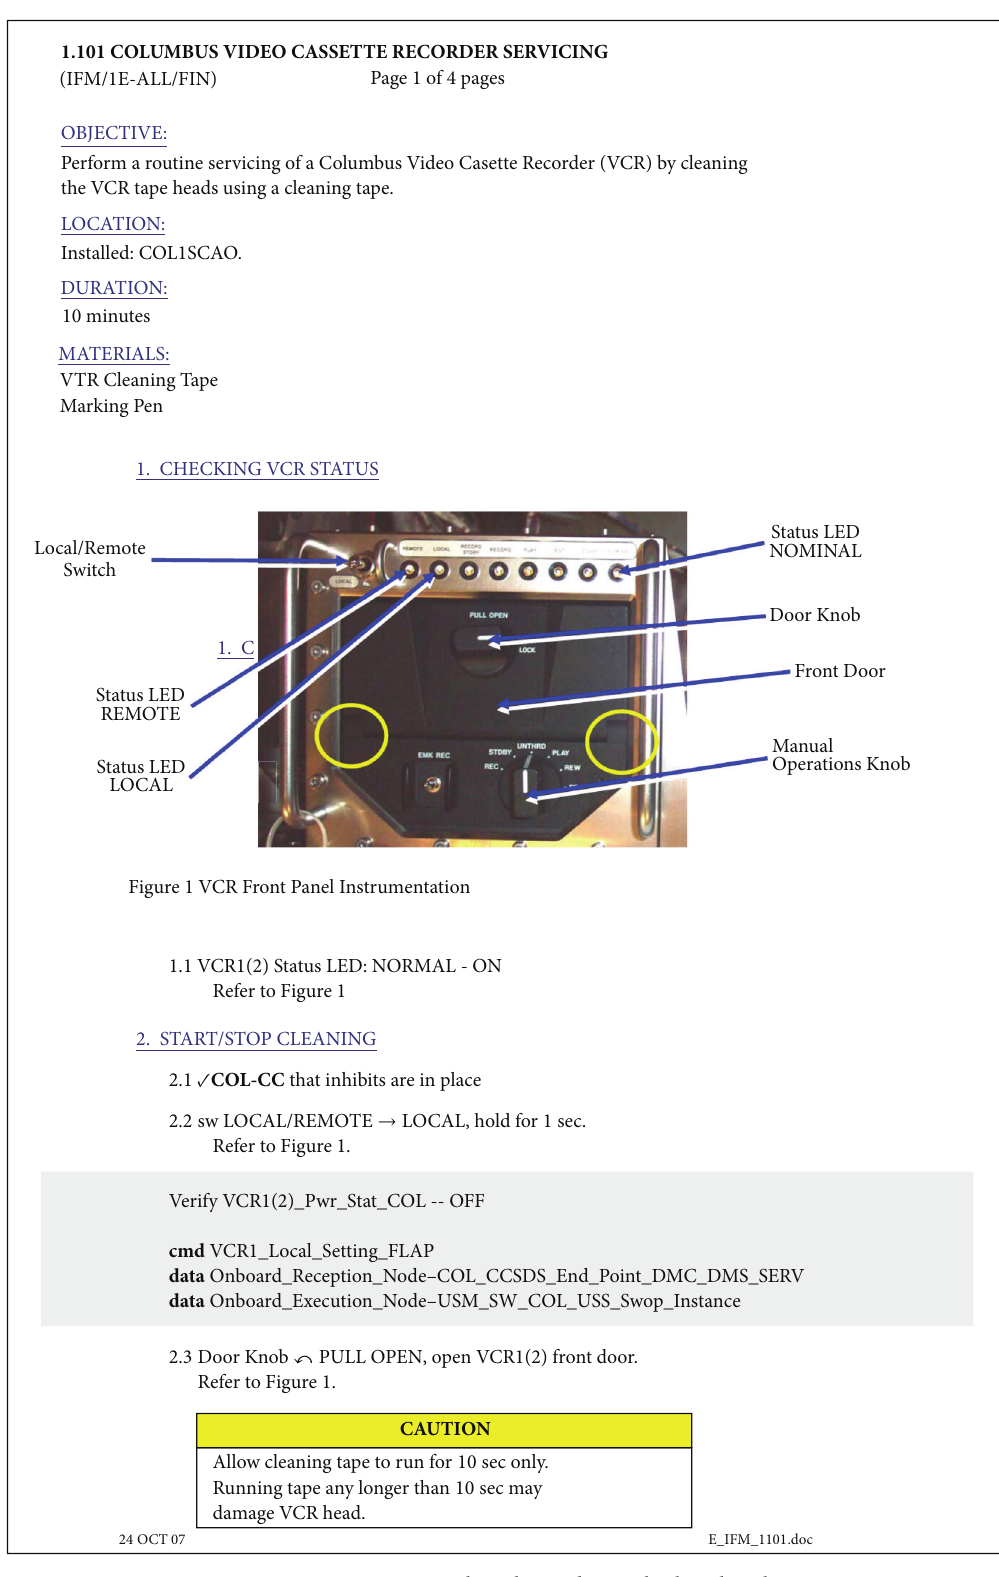
Figure 1: Operations Data File with mandatory check with